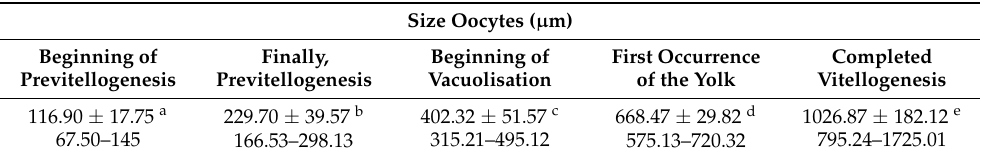
Table 3. Sizes of oocytes at different stages of vitellogenesis in stone moroko, Pseudorasbora parva . Data are presented as mean ± SD and